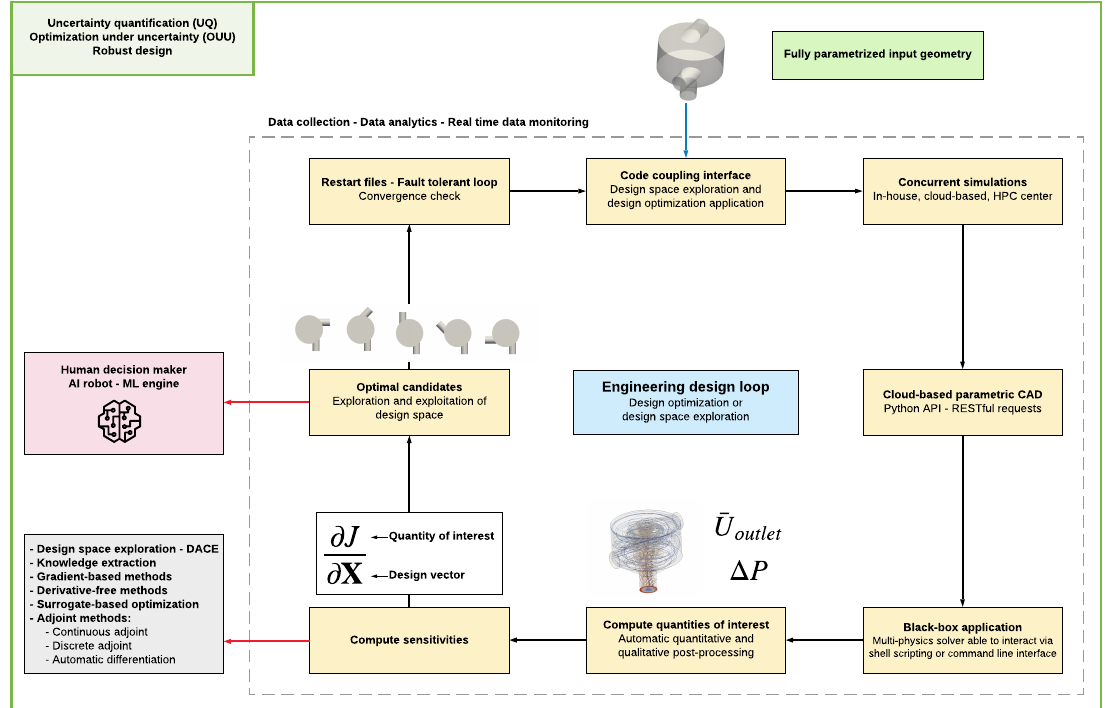
Figure 1. Graphical summary of the engineering design